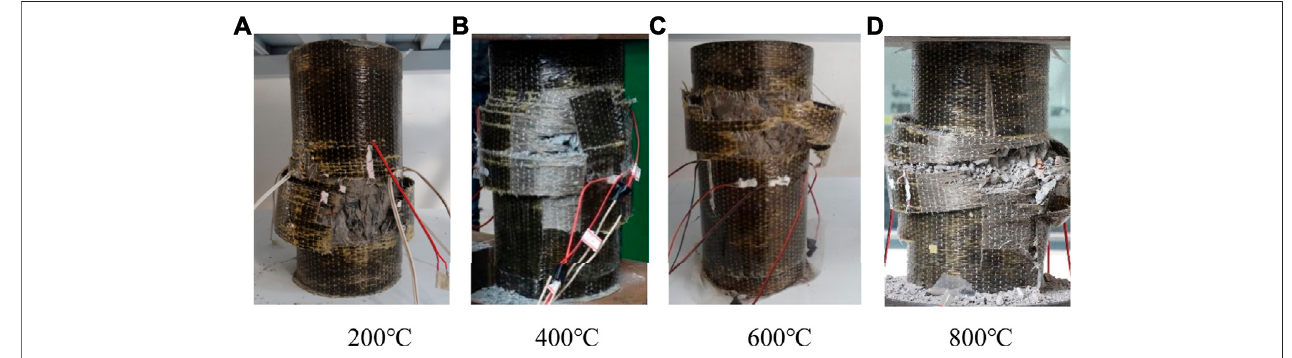
FIGURE 3 | Failure modes of BFRP-con fi ned heat-damaged concrete cylinders. (A) 200 ° C, (B) 400 ° C, (C) 600 ° C, (D) 800 °